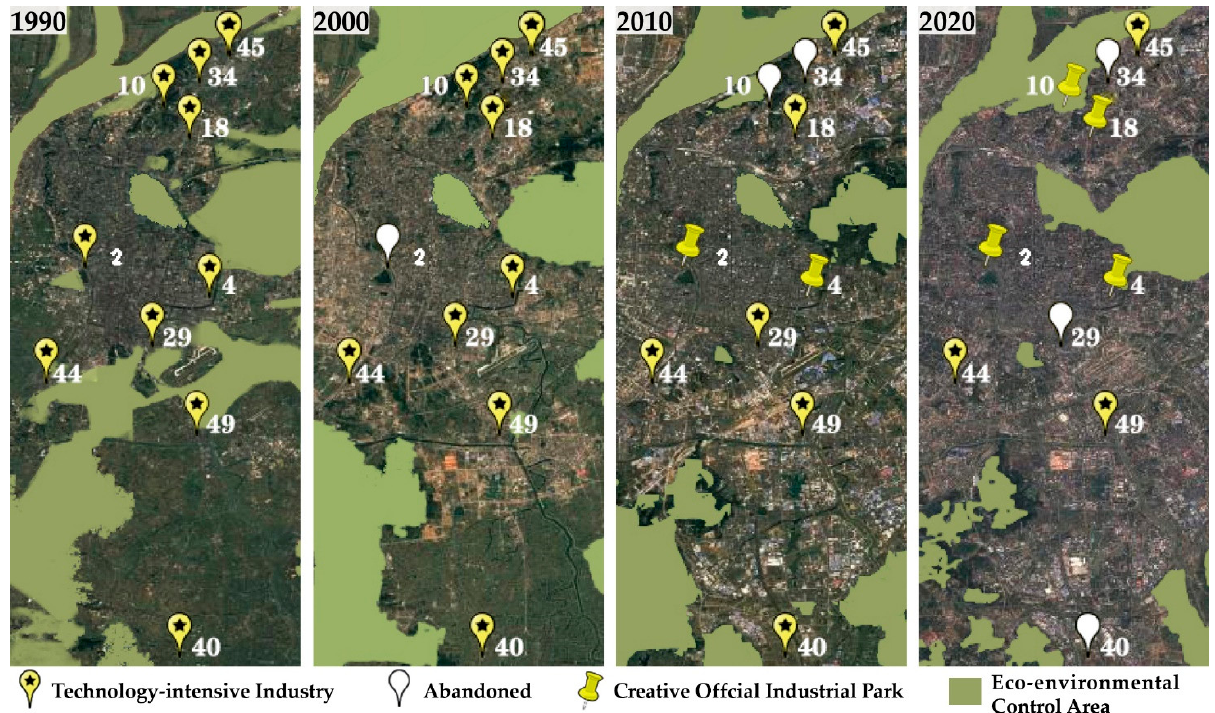
Figure 22. The change in the relationship between the operation state of technology-intensive industries and the eco-environmental control area over time (Figure source: own drawing; data source: on-site investigation and interview).